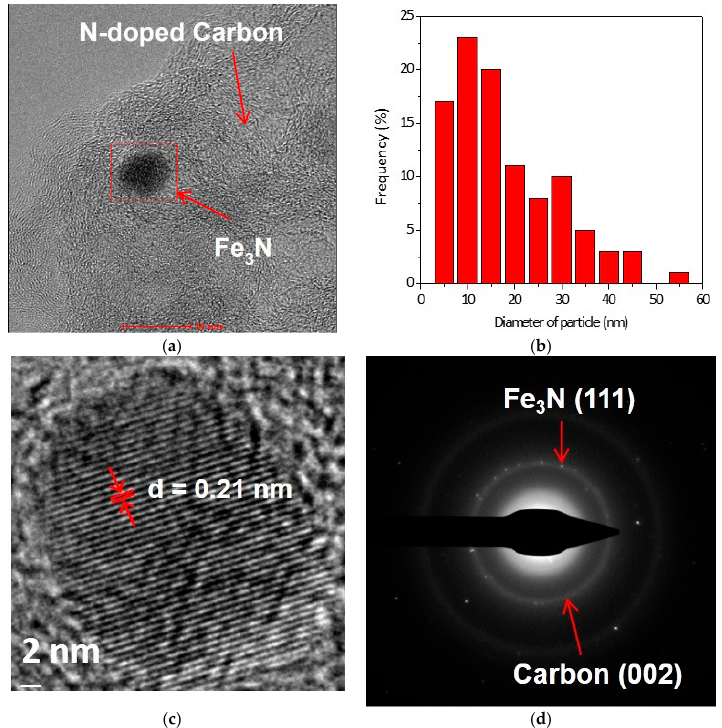
Figure 4. ( a ) Transmission electron microscope (TEM) image of Fe-N-C catalyst, ( b ) particle size distribution of Fe 3 N nanoparticles in Fe-N-C catalyst, ( c ) high resolution (HR)-TEM image of Fe 3 N nanoparticle, and ( d ) selected area electron diffraction (SAED) image of Fe-N-C catalyst. Catalysts 2016 , 6 , 86